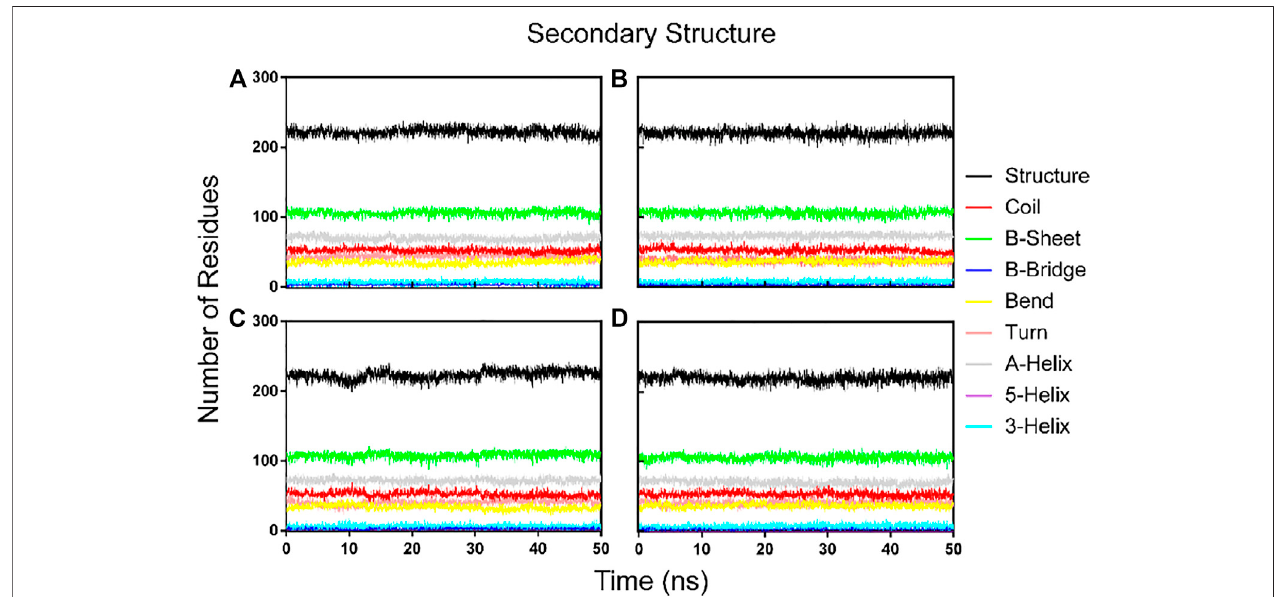
FIGURE 6 | Dynamics of evolution of secondary structure elements of the PLpro complex with hit 1 (A) , hit 2 (B) , hit 3 (C) , and hit4 (D) during the MD simulations.